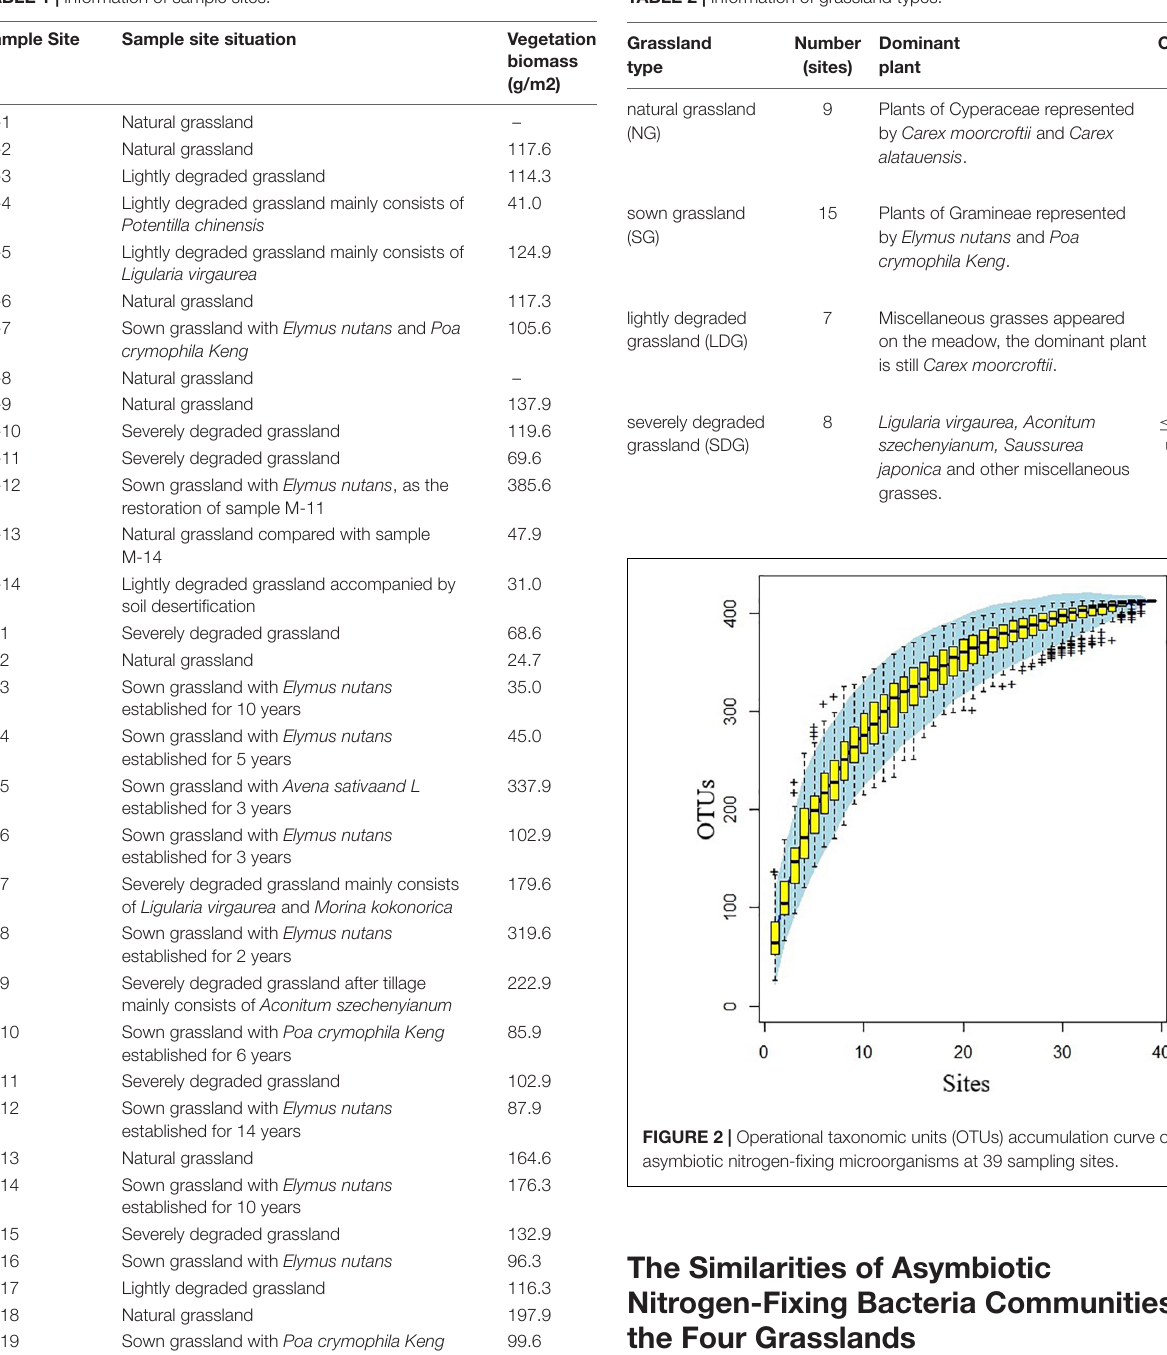
The Similarities of Asymbiotic Nitrogen-Fixing Bacteria Communities in the Four Grasslands Based on alpha diversity, the cluster analysis of ANF bacteria ( Figure 5 ) displayed that, except for LDG, Sphingomonas accounted for a large proportion of all grassland bacteria. Ochrobactrum was common in NG and LDG, whereas Pseudomonas and Flavobacterium , while not as widely distributed as those of the dominant bacteria, were most abundant in SG and SDG ( Figures 3 , 5 ). The distribution of Opitutus in alpine grassland was most uniform ( Figure 5